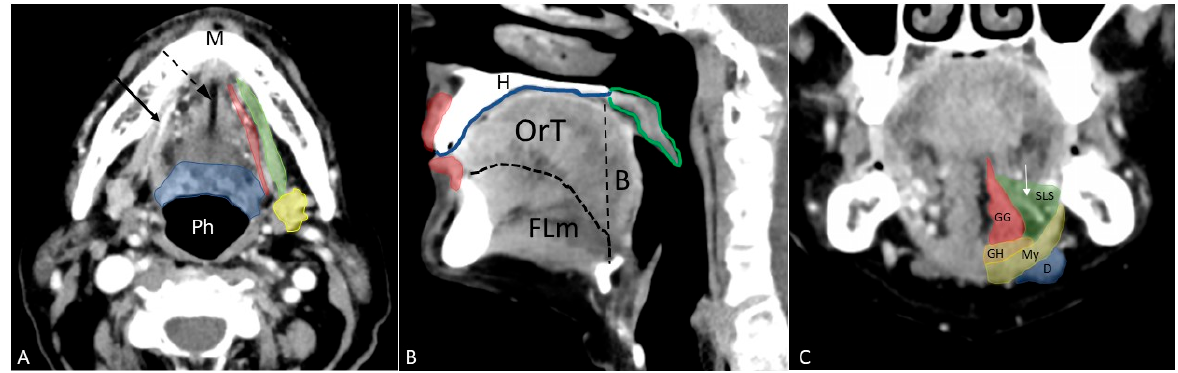
Figure 1. Anatomy of the oral cavity. ( A ) Axial contrast-enhanced MSCT image showing the floor of the mouth, a U-shaped space bounded inferiorly by the mylohyoid muscle (green). The floor of the mouth contains the extrinsic musculature of the tongue and the sublingual space (see Figure 1C) with the deep portion of the submandibular gland (yellow). M: mandible. Arrow: lingual artery. Dotted arrow: lingual septum. Red: hyoglossus muscle. Blue: base of the tongue which is part of the oropharynx and not of the oral cavity. Ph: pharynx. ( B ) Sagittal contrast-enhanced MSCT image showing the division of the tongue (OrT: oral tongue with intrinsic muscles. FLm: floor of the mouth with extrinsic muscles. B: base of the tongue). Bony hard palate (H) and lips (red), subsites of the oral cavity. Green: soft palate and uvula, which are part of the oropharynx and not of the oral cavity. ( C ) Coronal contrast-enhanced MSCT image showing in detail the floor of the mouth and sublingual space. GG: genioglossus muscle. GH: geniohyoid muscle. My: mylohyoid muscle. D: anterior belly of digastric muscle. SLS: sublingual space with lingual artery inside (arrow). SLS contains anterior fibers of the m. hyoglossus, lingual artery, vein and nerve, glossopharyngeal (IX) and hypoglossal (XII) nerves, sublingual gland and deep lobe of submandibular gland with Wharton’s duct (these structures are not annotated in the image).